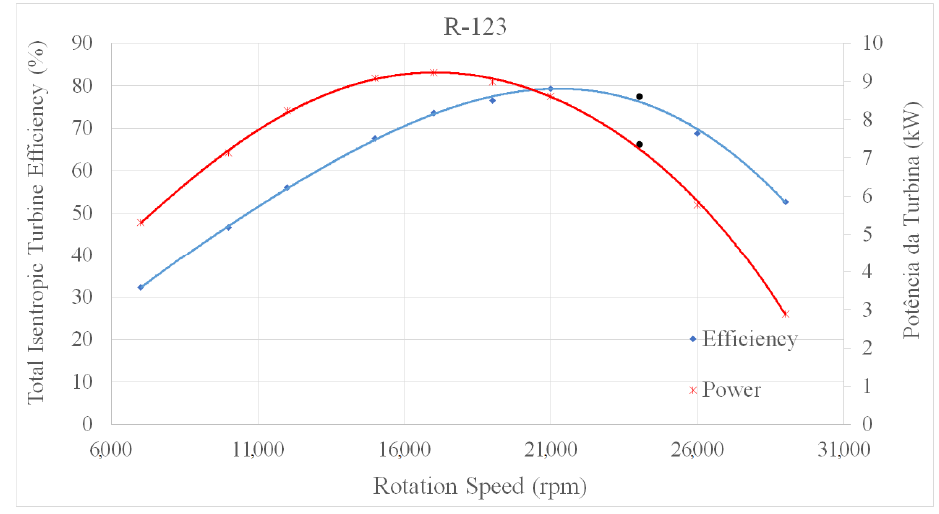
Figure 18. Variation in the total isentropic efficiency and power of the turbine operating with R ‐ 123, as a function of rotation